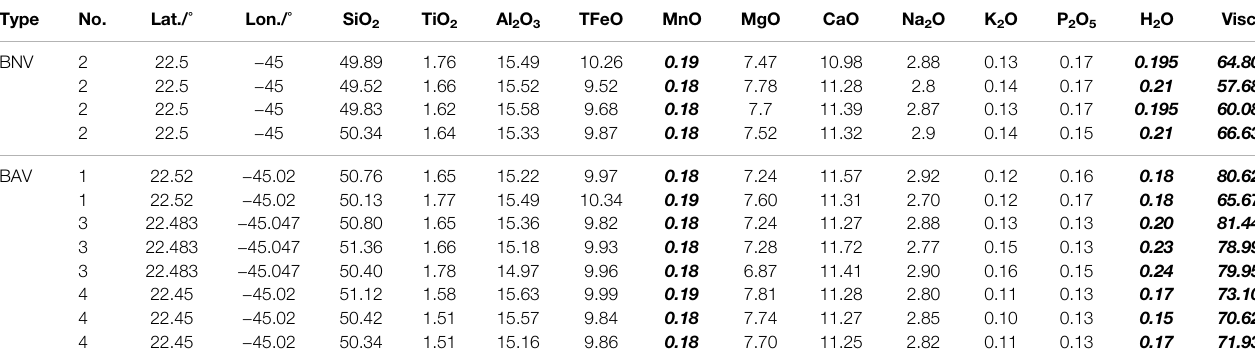
TABLE 8 | Major elements (wt%) and viscosity of basalt (Pa · s) on MAR 22 ° 30 ′ N vent (data from PetDB). Type No. Lat./ °